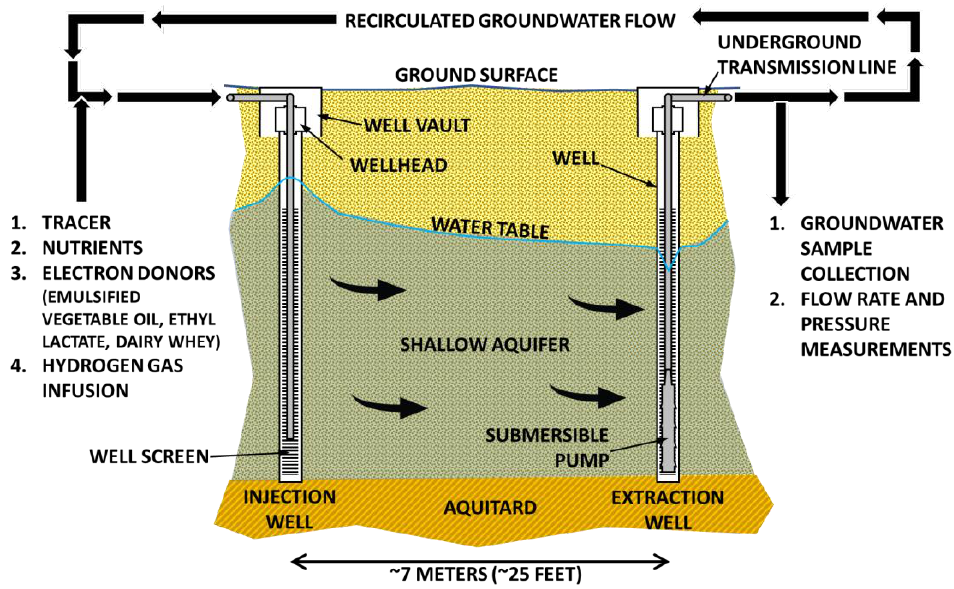
Figure 3. Cross-section of a typical test cell. Induced flow between the injection and extraction wells is shown.